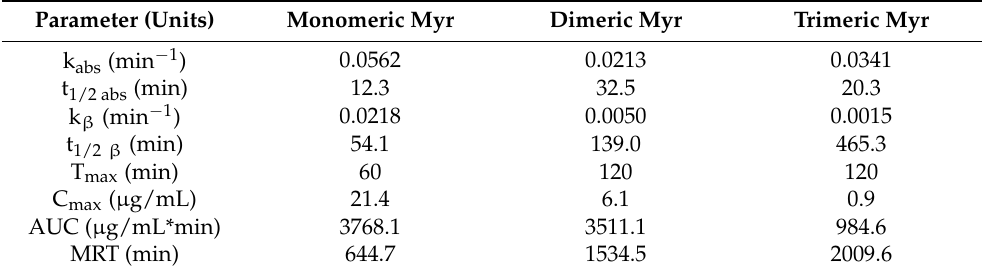
Table 5. Pharmacokinetic parameters of three myristic variants after 7 days period injection adapted from Biscan et